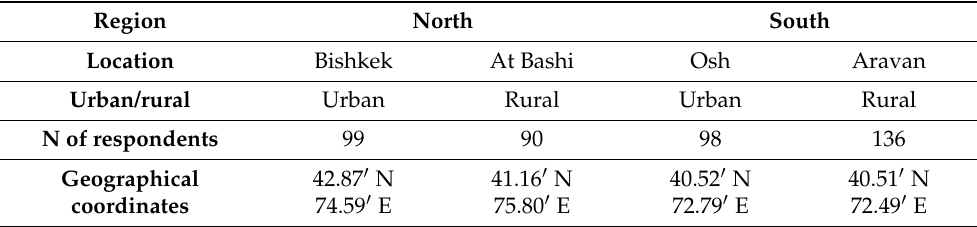
Table 1. Study area information.